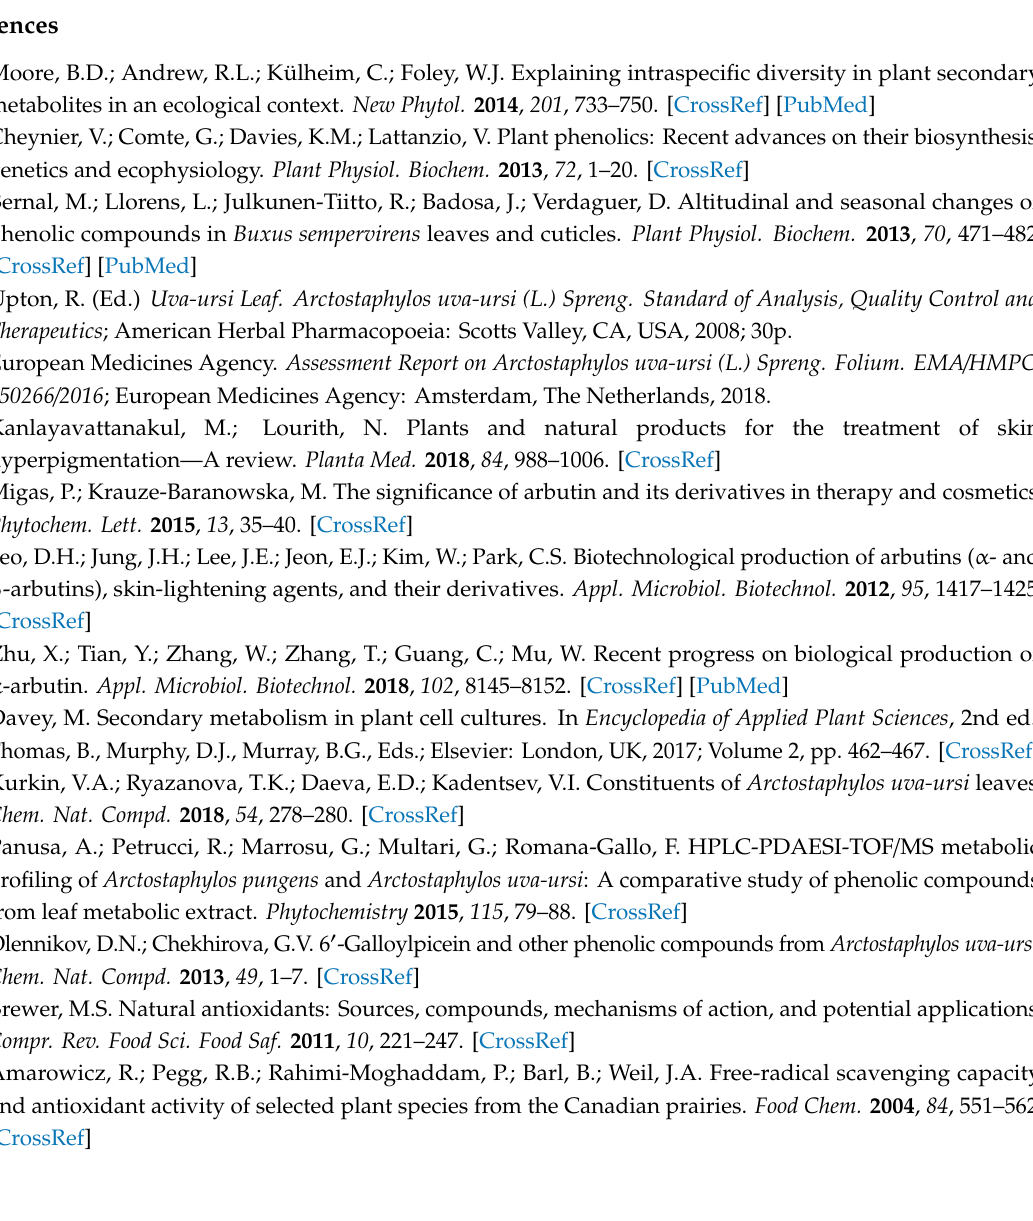
only for genetic and cytogenetic studies. Table S2: GenBank accession numbers of the plastid intergenic regions rpl32-trnL and psbE-petN, as well as the nuclear ribosomal DNA region ITS, of 105 bearberry plants from the Iberian Peninsula. Figure S1. Example of chromatograms obtained for the 5 phenolic standards: A, arbutin; C, catechin; F, ca ff eic acid; QG, quercetin-o-glucoside; and M,